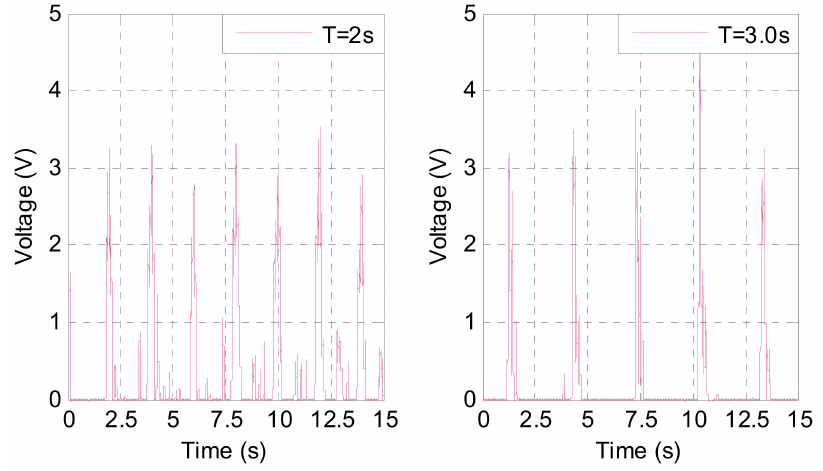
Figure 19. Output voltage curve of the